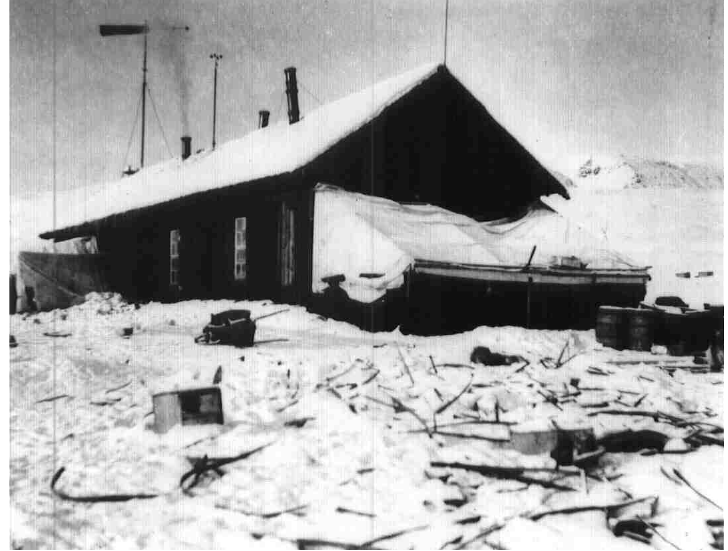
Figure 5. Historic photograph of the Greely station house.